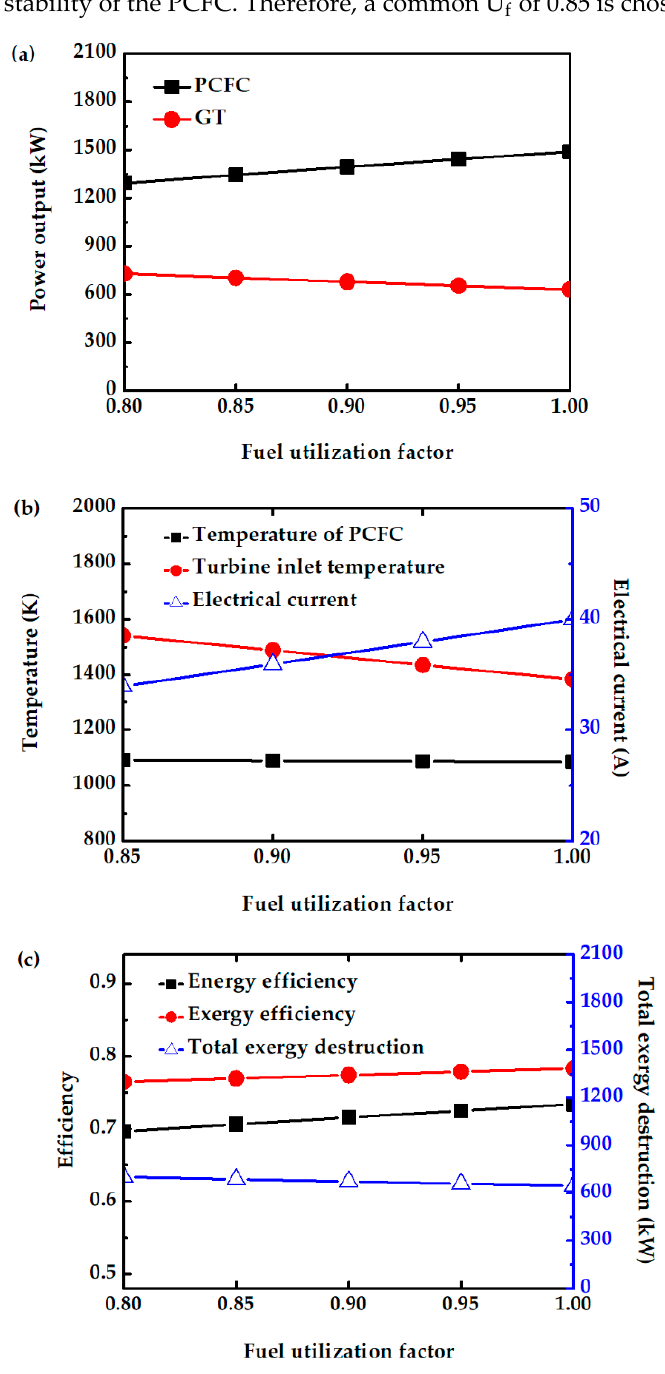
Figure 8. Effect of U f on ( a ) power output of PCFC and GT, ( b ) electrical current of PCFC and turbine inlet temperature, and ( c ) energy efficiency, exergy efficiency, and total exergy destruction.